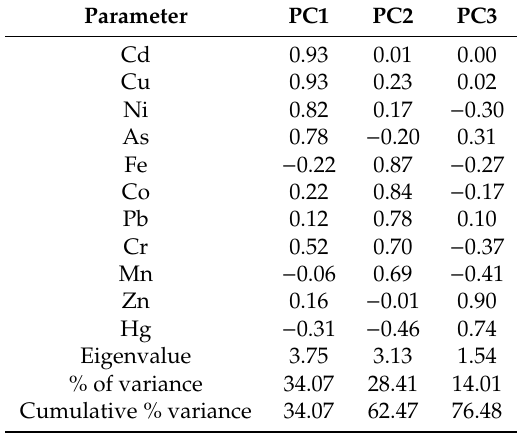
Table 2. Variance explained and component matrixes for heavy contents ( n =